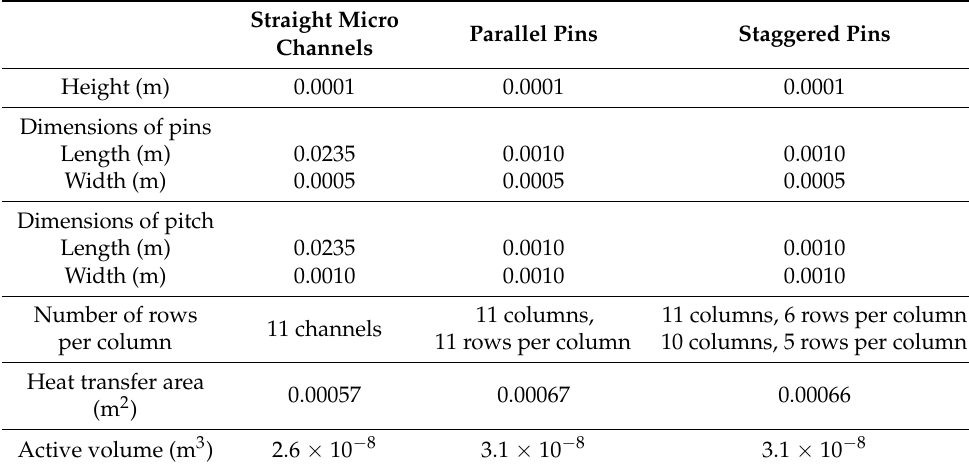
Table 4. Dimensions of the experimentally tested microstructures.